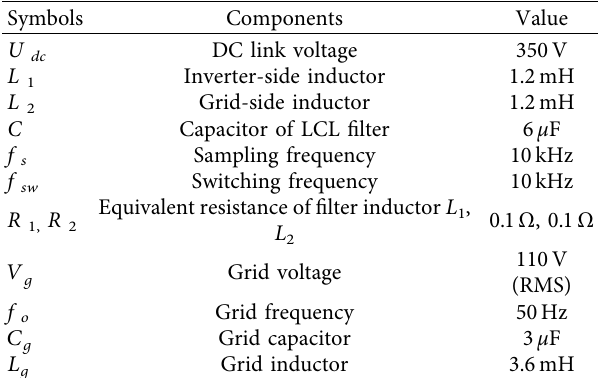
Figure 3: Norton equivalent model. Table 1: System parameters.